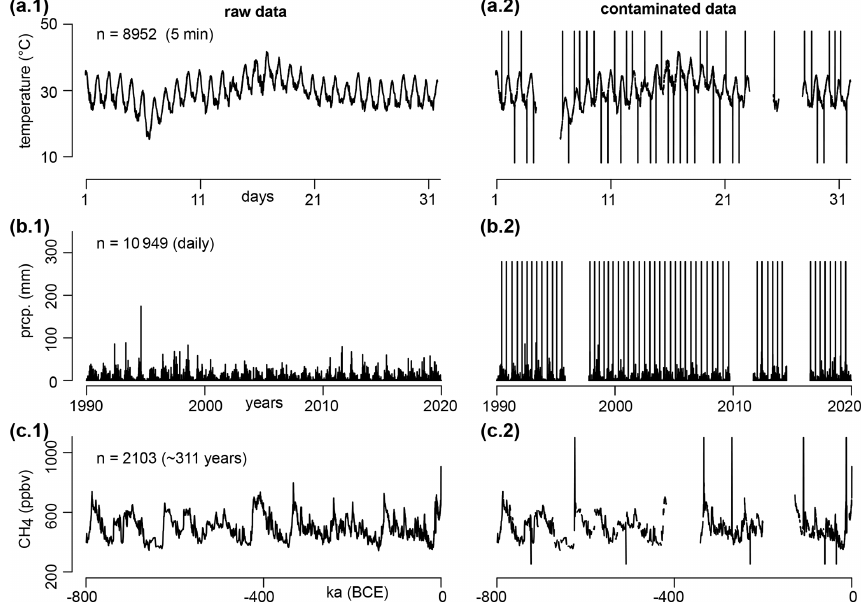
Figure 5. Raw and contaminated versions of the three datasets used as case studies: temperature (a) , precipitation (b) , and methane (c) . The sampling frequency is given in parenthesis. The contaminated versions contain three large data gaps (20% of the datasets), random missing values (9.5%), and random outliers (0.5%) set as a constant